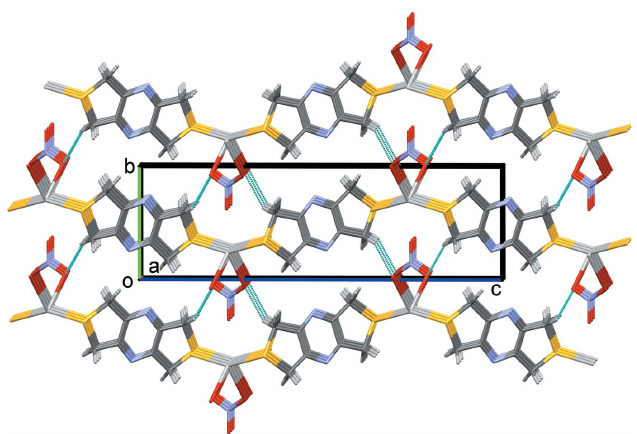
Figure 8 Aview along the a axis of the crystal packing of complex I . The hydrogen bonds are shown as dashed lines (Table 3).